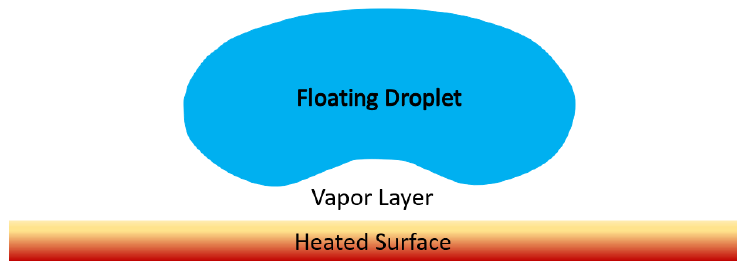
Figure 3. The Leidenfrost phenomenon forms vapor layer preventing droplet from contacting the surface.